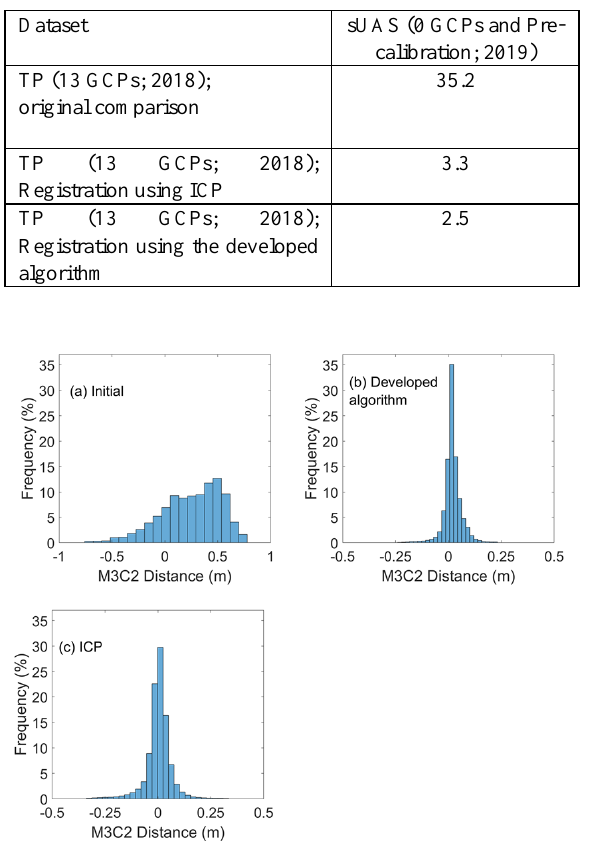
Figure 6. Histograms for TP (13 GCPs; 2018) and sUAS (0 GCPs and Pre-calibration; 2019) comparison (a) initial comparison; (b) Registration using the developed algorithm; (c) Registration using the ICP algorithm.